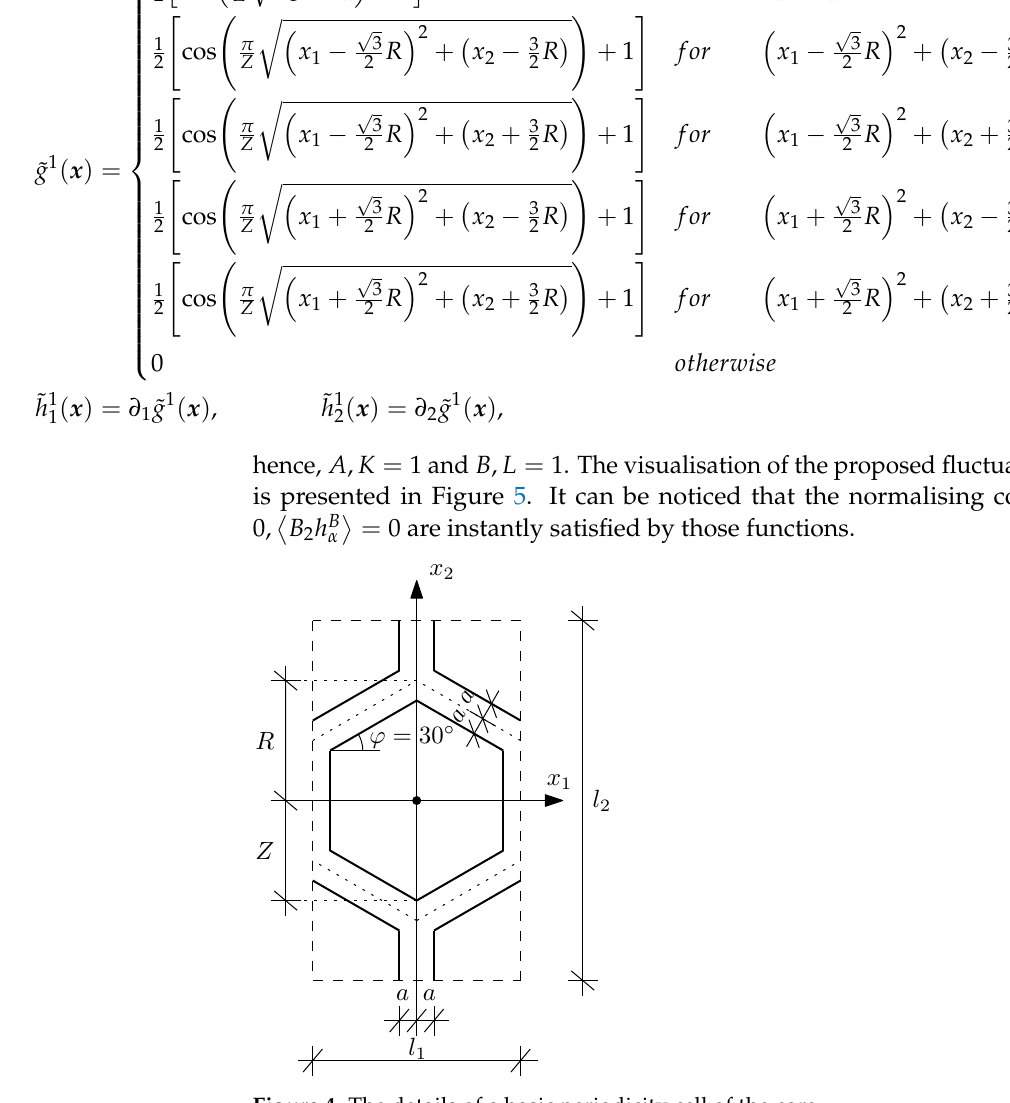
Figure 4. The details of a basic periodicity cell of the